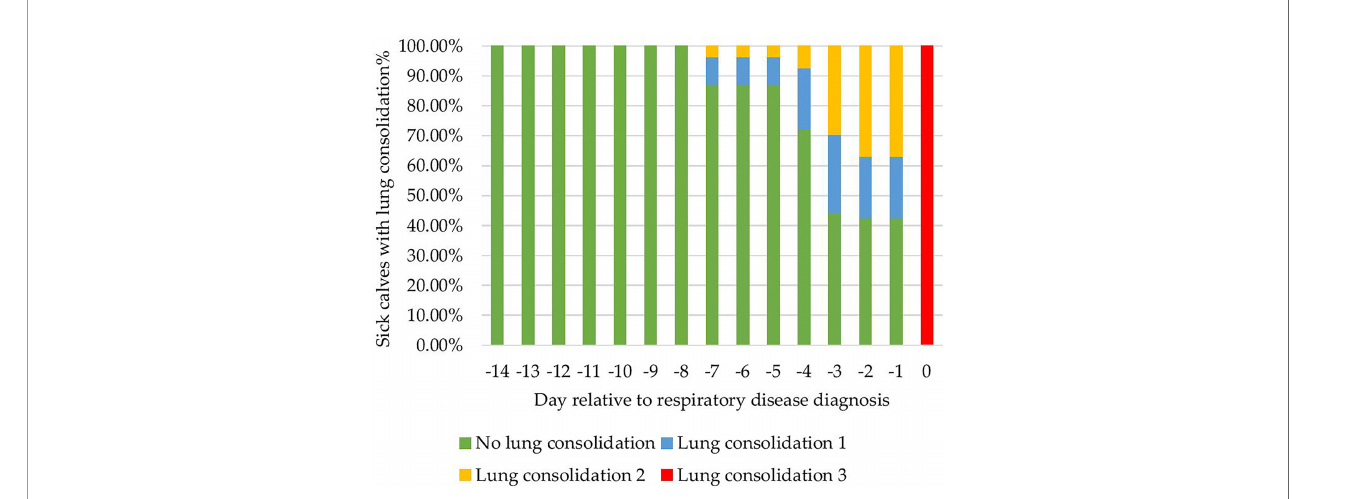
FIGURE 4 | Proportion of 54 calves with lung consolidation in the 14 days prior to clinical bovine respiratory disease